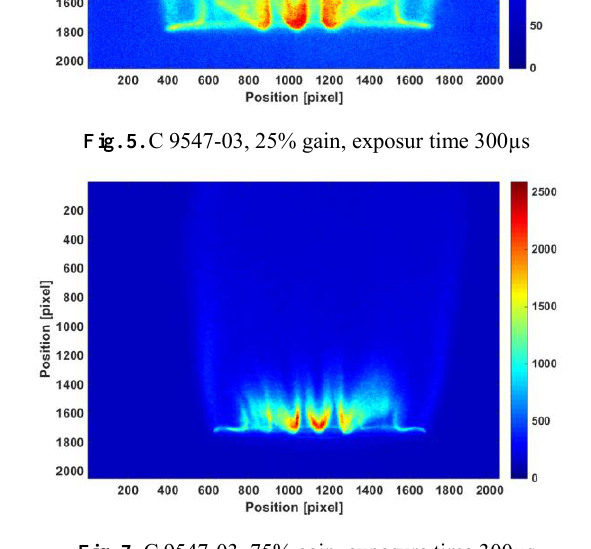
Fig. 8. C 9547-03, 75% gain, exp. time 300µs , cross-section